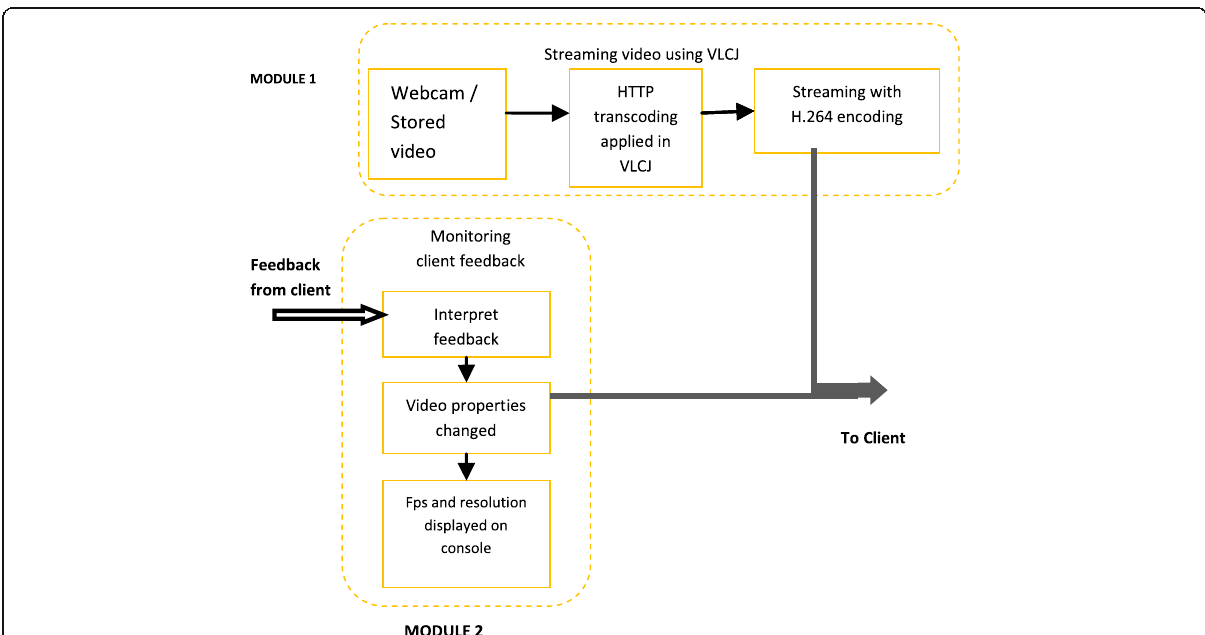
Fig. 4 Server side modules. The server ’ s main function includes capturing and transcoding of video frames at a different quality based on client